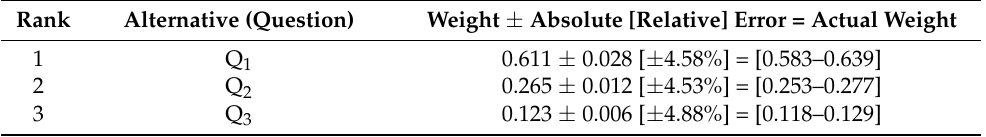
Table 4. Alternatives’ weights and mean errors.